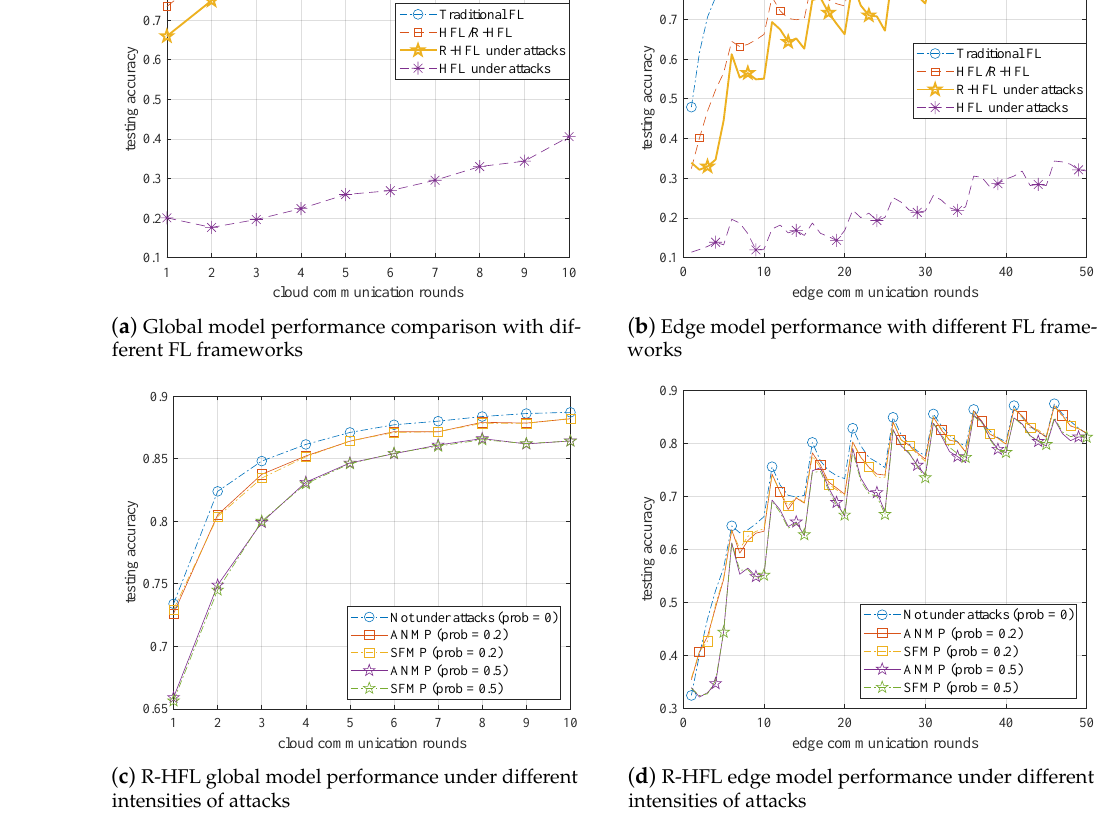
Figure 2. Performance evaluation (i) with different FL frameworks as ( a , b ), and (ii) under different intensities of attacks as ( c , d